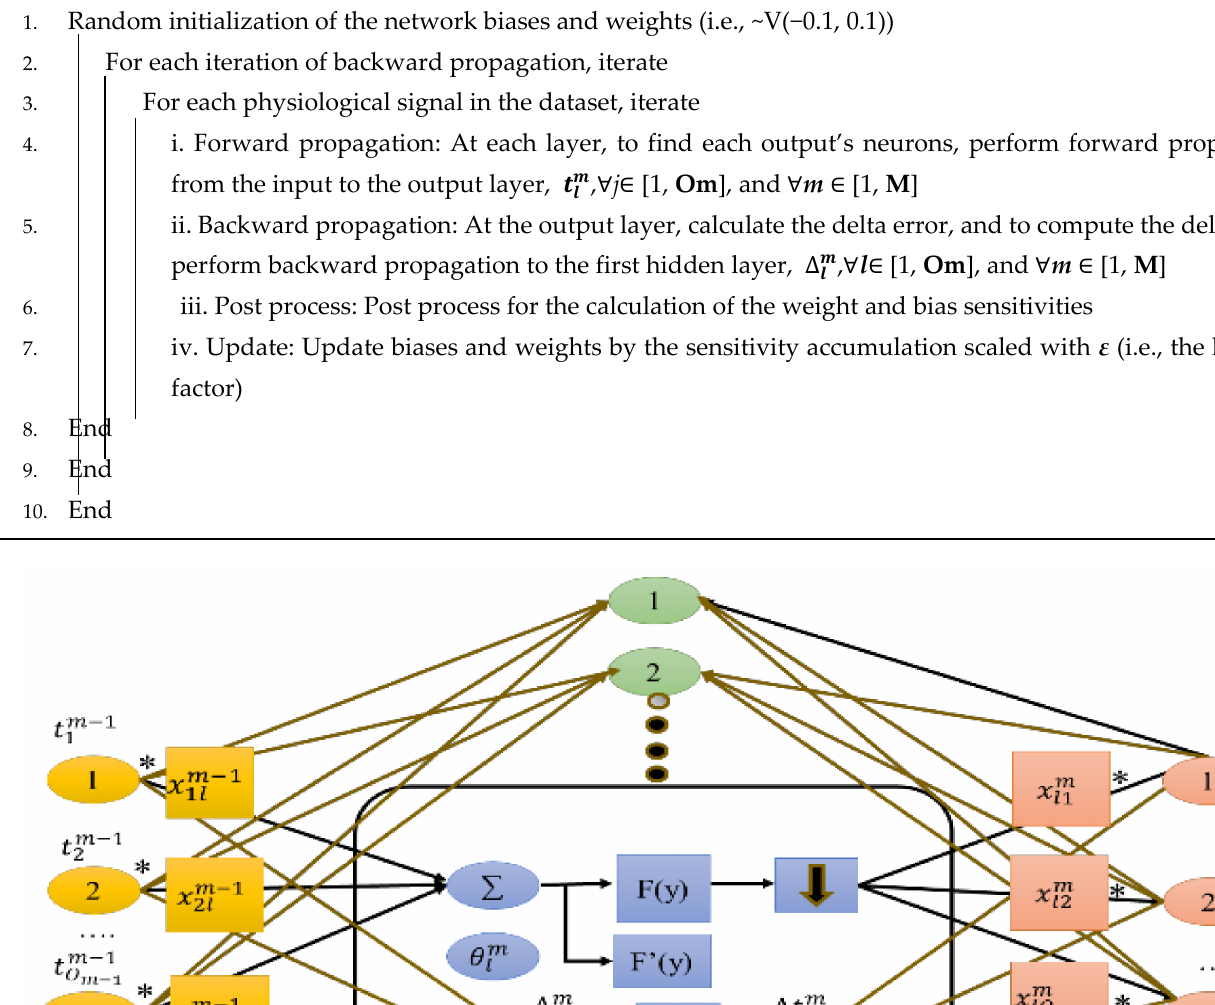
Figure 3. Backward and forward propagation in the one-dimensional convolutional neural network (ODCNN). Where * represents the product function during forward and backward propagation procedures. Algorithm 1. Backward and forward propagation in the one-dimensional convolutional neural network (ODCNN)